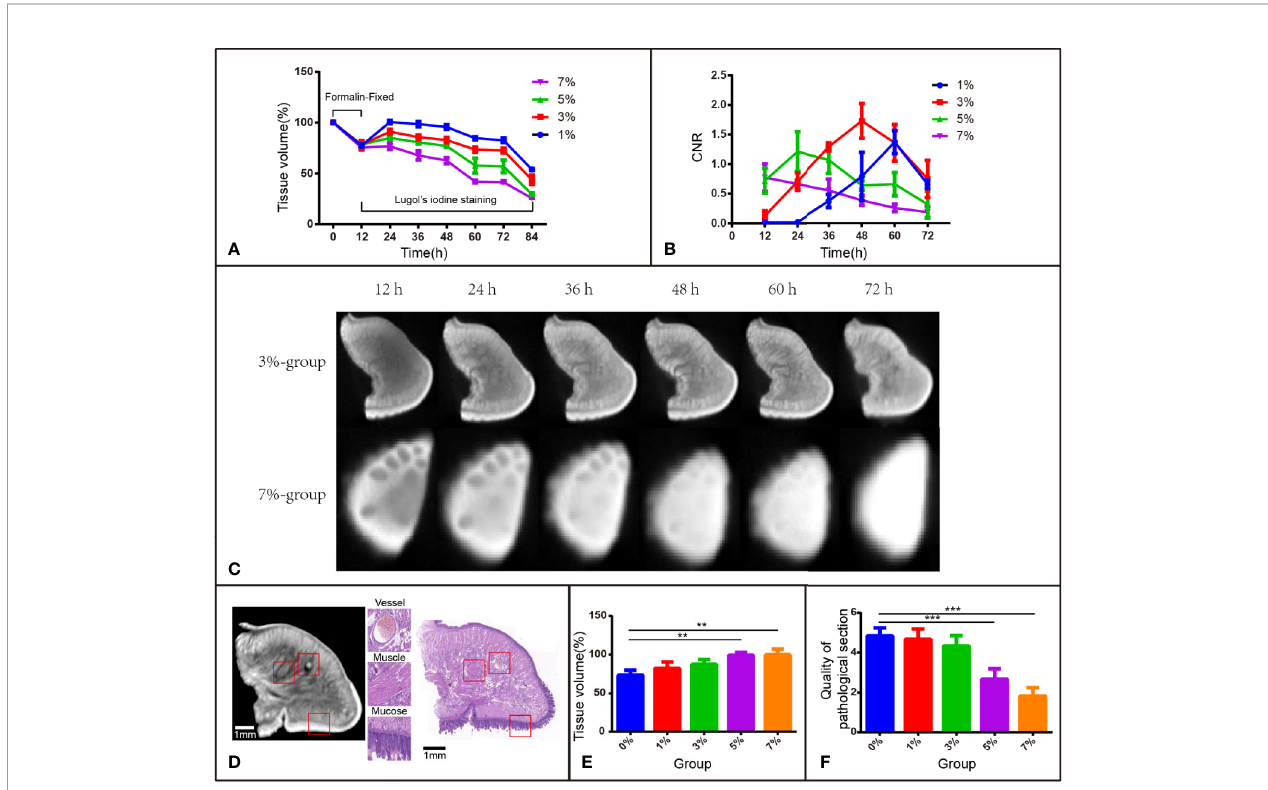
FIGURE 1 | I 2 -IK-enhanced micro-CT image for rabbit tongue tissues. (A) Tissue shrinkage during formalin fi xation and I 2 -IK staining (tissue volume normalized to 100%). (B) CNR value of micro-CT image at different times with different concentrations of I 2 -IK. (C) Micro-CT image data at different times with 3% and 7% I 2 -IK staining. (D) Micro-CT image and H&E image of the same sections (the structures in the red box indicate mucous, muscle fi bers, and blood vessels). (E) Tissue shrinkage during H&E staining. (F) The quality of H&E images with different concentrations of I 2 -IK. (** P < 0.01, *** P <